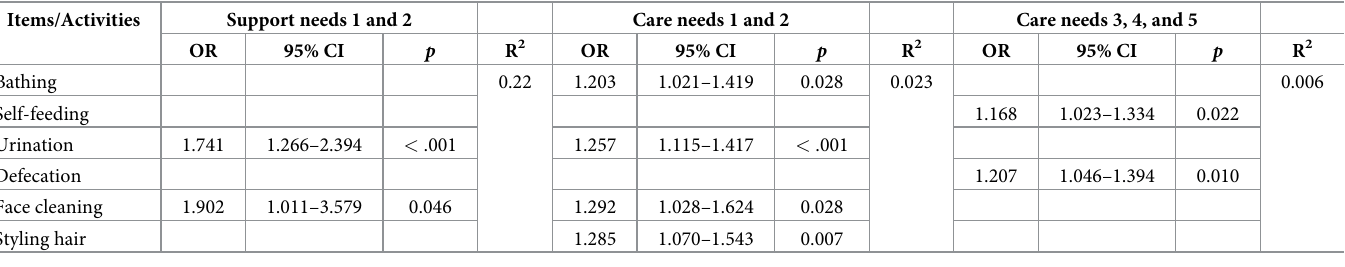
Table 3. Risk factors for nursing home placement related to activities of daily